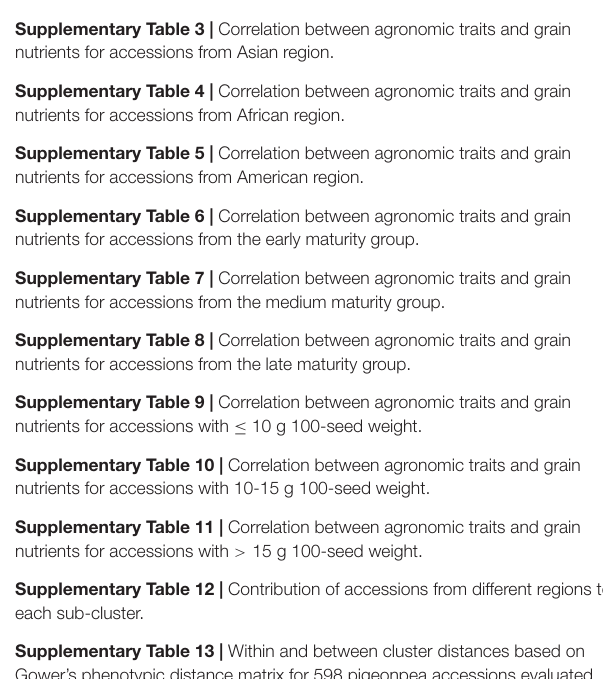
Supplementary Table 1 | Metadata of the 600 pigeonpea accessions and four checks evaluated for agronomic traits and grain nutrients during the 2019 and 2020 rainy seasons at ICRISAT, India. Supplementary Table 2 | Correlation among agronomic traits and grain nutrients of 598 pigeonpea accessions evaluated during the 2019 and 2020 rainy seasons at ICRISAT, India. Supplementary Table 3 | Correlation between agronomic traits and grain nutrients for accessions from Asian region. Supplementary Table 4 | Correlation between agronomic traits and grain nutrients for accessions from African region. Supplementary Table 5 | Correlation between agronomic traits and grain nutrients for accessions from American region. Supplementary Table 6 | Correlation between agronomic traits and grain nutrients for accessions from the early maturity group. Supplementary Table 7 | Correlation between agronomic traits and grain nutrients for accessions from the medium maturity group. Supplementary Table 8 | Correlation between agronomic traits and grain nutrients for accessions from the late maturity group. Supplementary Table 9 | Correlation between agronomic traits and grain nutrients for accessions with ≤ 10 g 100-seed weight. Supplementary Table 10 | Correlation between agronomic traits and grain nutrients for accessions with 10-15 g 100-seed weight. Supplementary Table 11 | Correlation between agronomic traits and grain nutrients for accessions with > 15 g 100-seed weight. Supplementary Table 12 | Contribution of accessions from different regions to each sub-cluster. Supplementary Table 13 | Within and between cluster distances based on Gower’s phenotypic distance matrix for 598 pigeonpea accessions evaluated during the 2019 and 2020 rainy seasons at ICRISAT, India. Supplementary Table 14 | Mean and range comparison for agronomic traits and grain nutrients between six sub-clusters of 598 pigeonpea accessions evaluated during the 2019 and 2020 rainy seasons at ICRISAT,